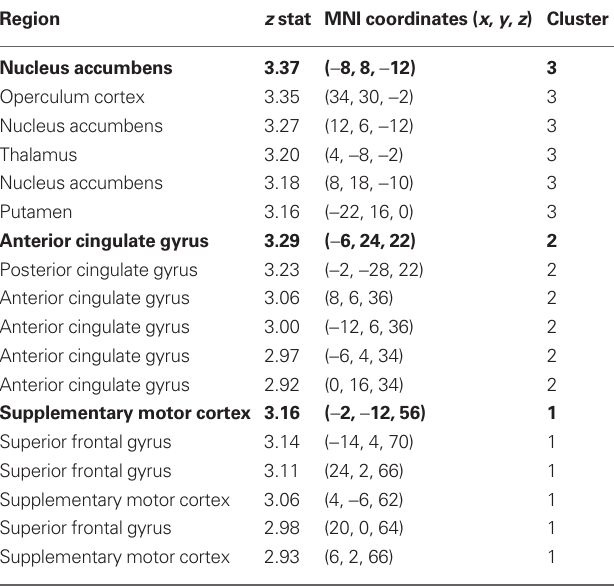
Table 4 | Maxima for candy group and money group